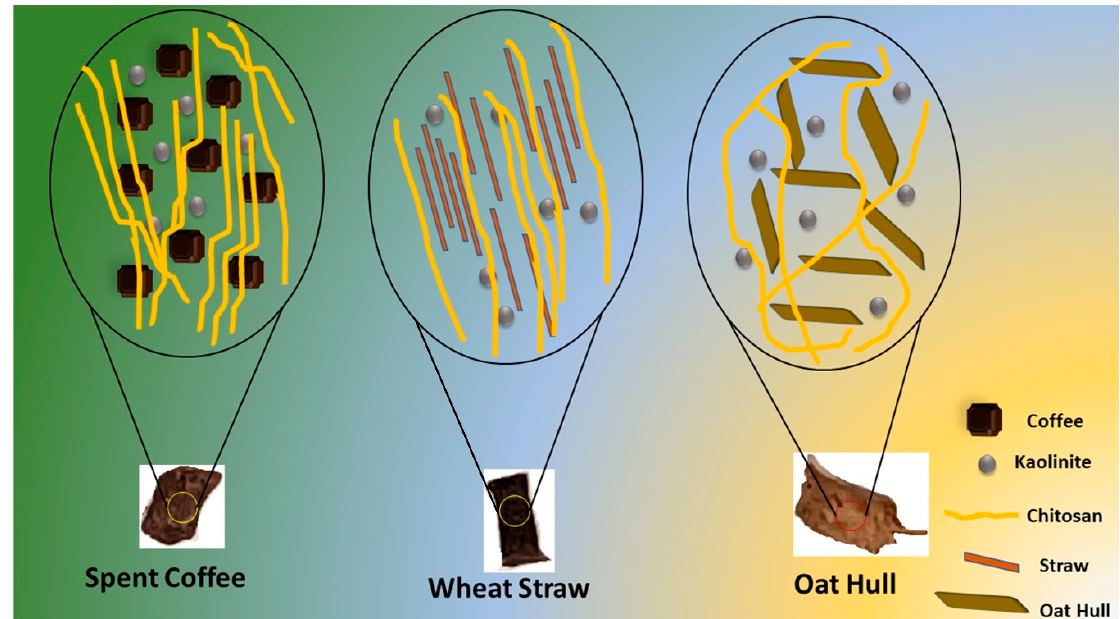
Figure 7. Schematic illustration of the pelletized NCL composites that conceptually illustrate different morphologies and densities between biomass particles (SCG, S, and Oh) within a matrix containing chitosan and